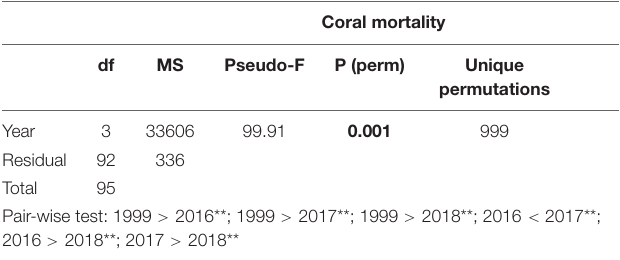
TABLE 4 | Results of one-way PERMANOVA on coral mortality in shallow reefs (5 m depth) among the years when coral mortality occurred (i.e., 1999, 2016, 2017, and 2018).